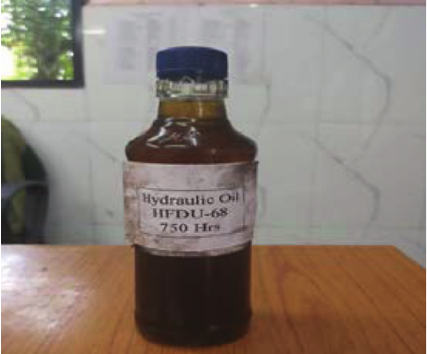
Figure 8: 750-hour used oil